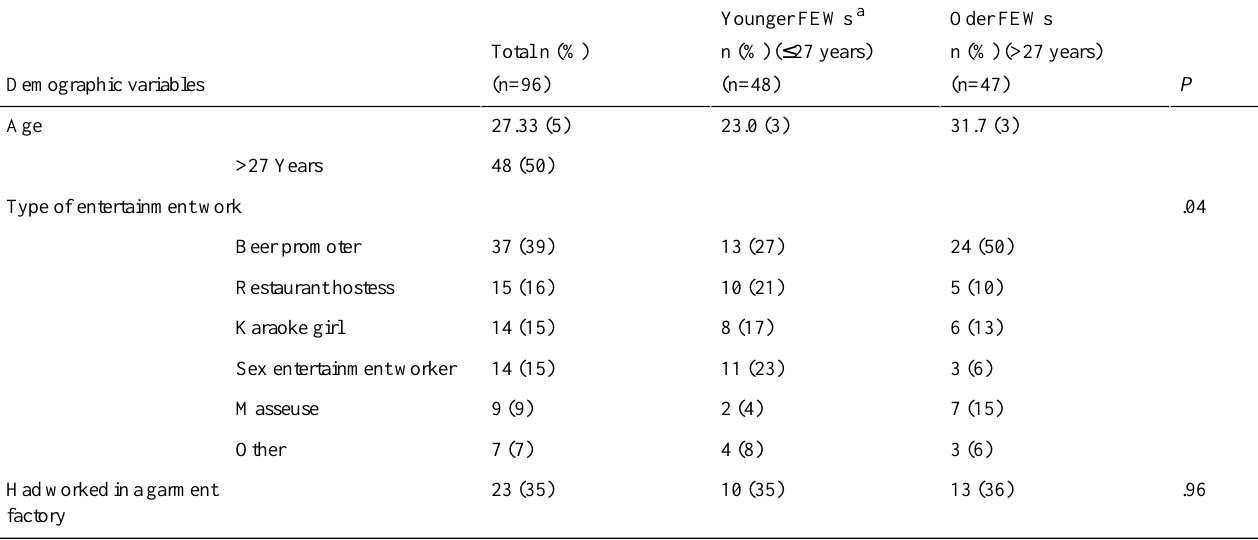
Table 1. Demographic data of study participants by age group (n=96).